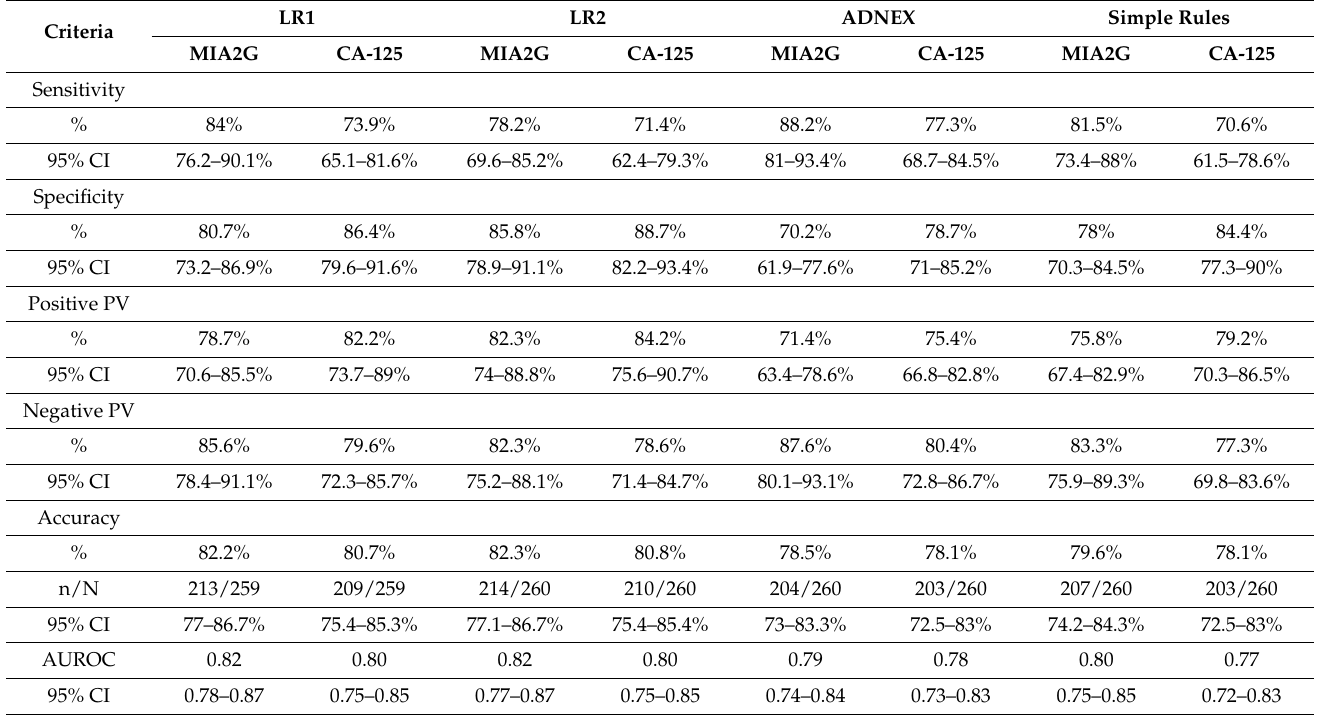
Table 5. Performance of serial testing with biomarker assays and imaging in the identification of ovarian